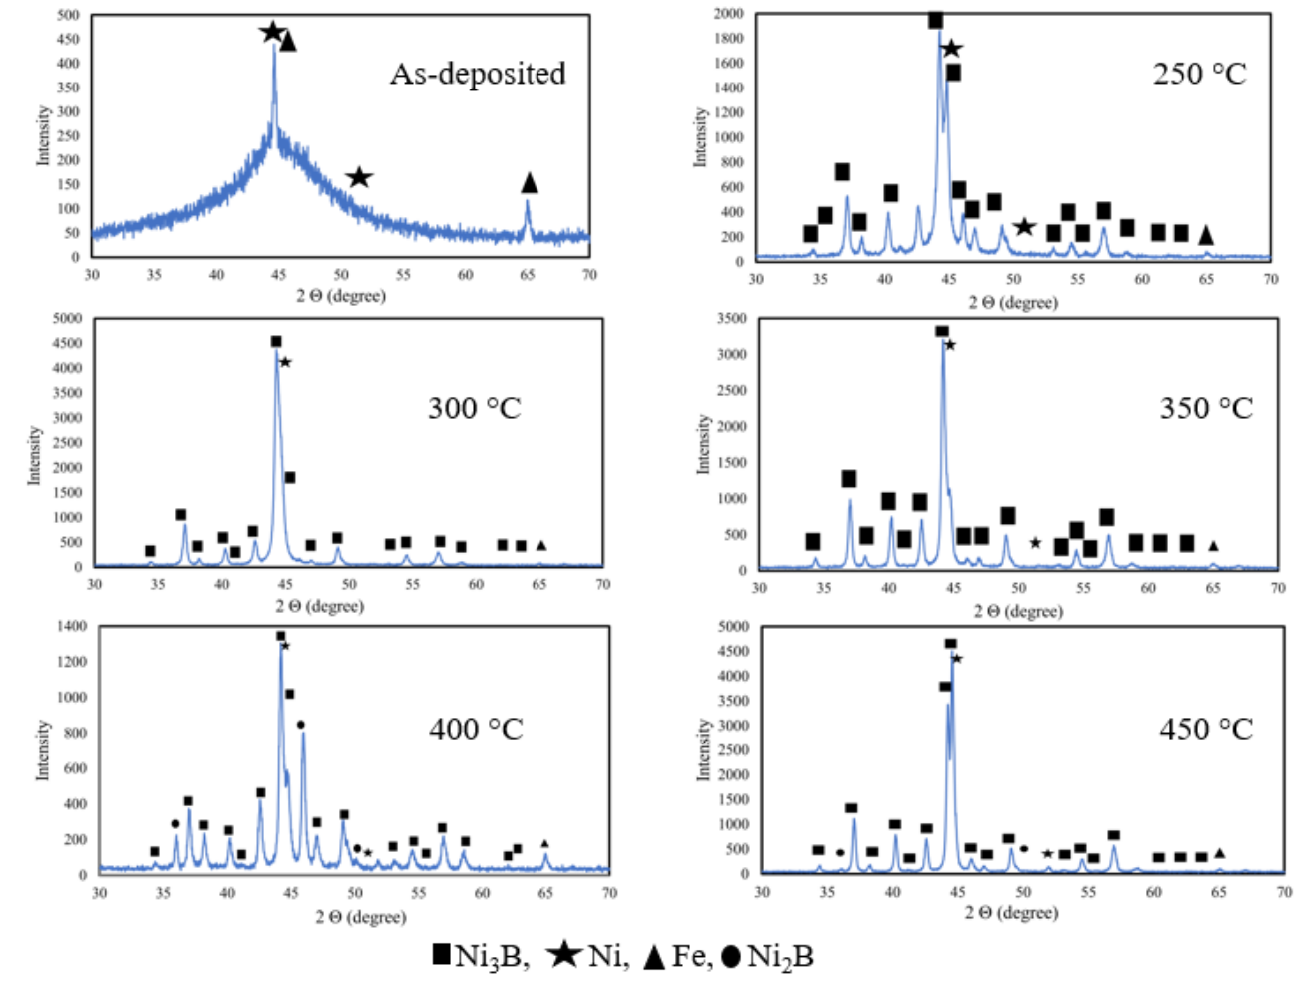
Figure 2. XRD data of the ENB deposits before and after heat treatment at 250 °C, 300 °C, 350 °C, 400 °C, and 450 °C for 1 h.